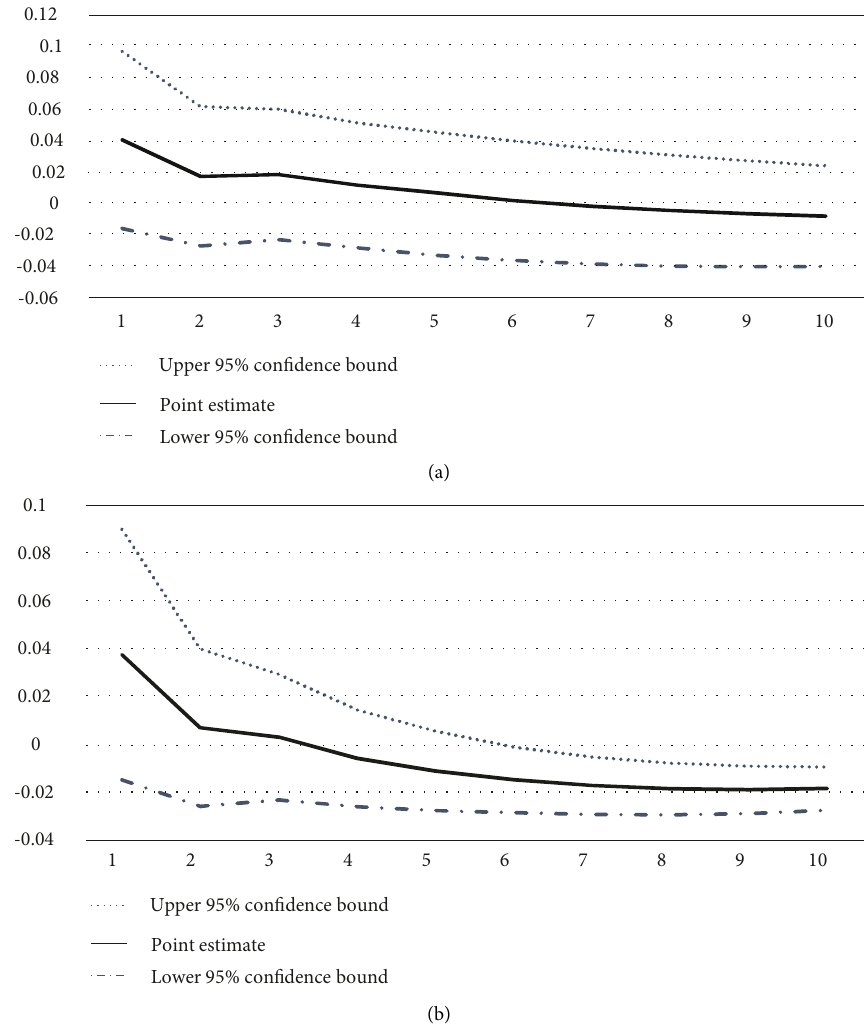
Figure 6: Impulse response estimates of marketability efficiency by the financial crises in 2001 (a) and 2009 (b) with 95% confidence